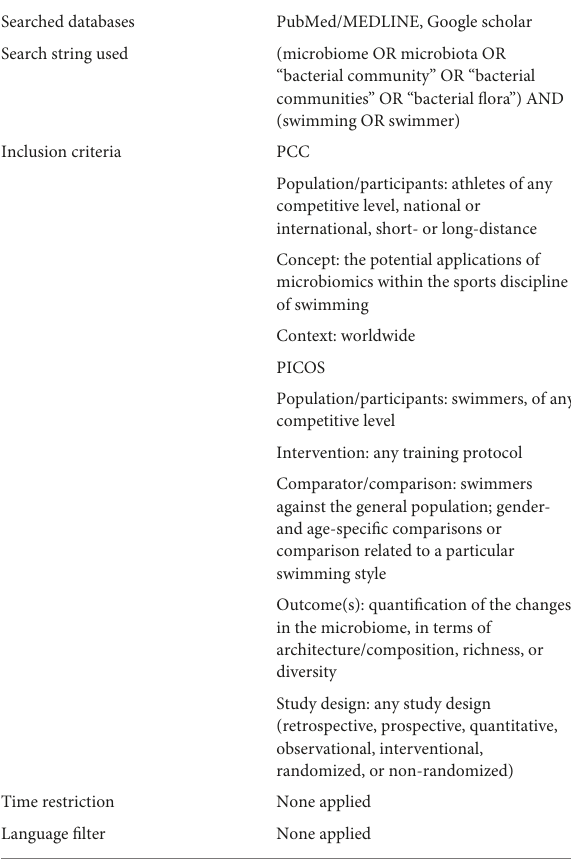
TABLE 2 Search strategy adopted in the present scoping